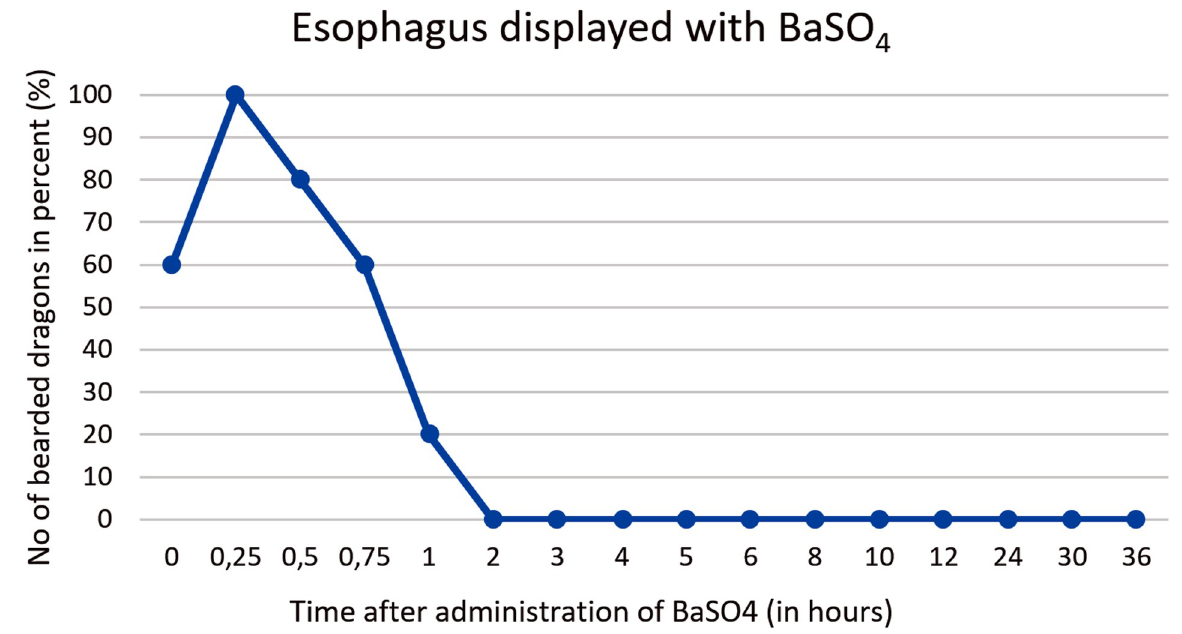
Fig 7. BaSO 4 contrast visibility in the esophagus over time. Percentage of animals and frequency at measuring time point; y = number of animals in percent (%) in which contrast media could be found in the esophagus; x = time point during the barium sulfate (BaSo 4 ) contrast passage (hours).